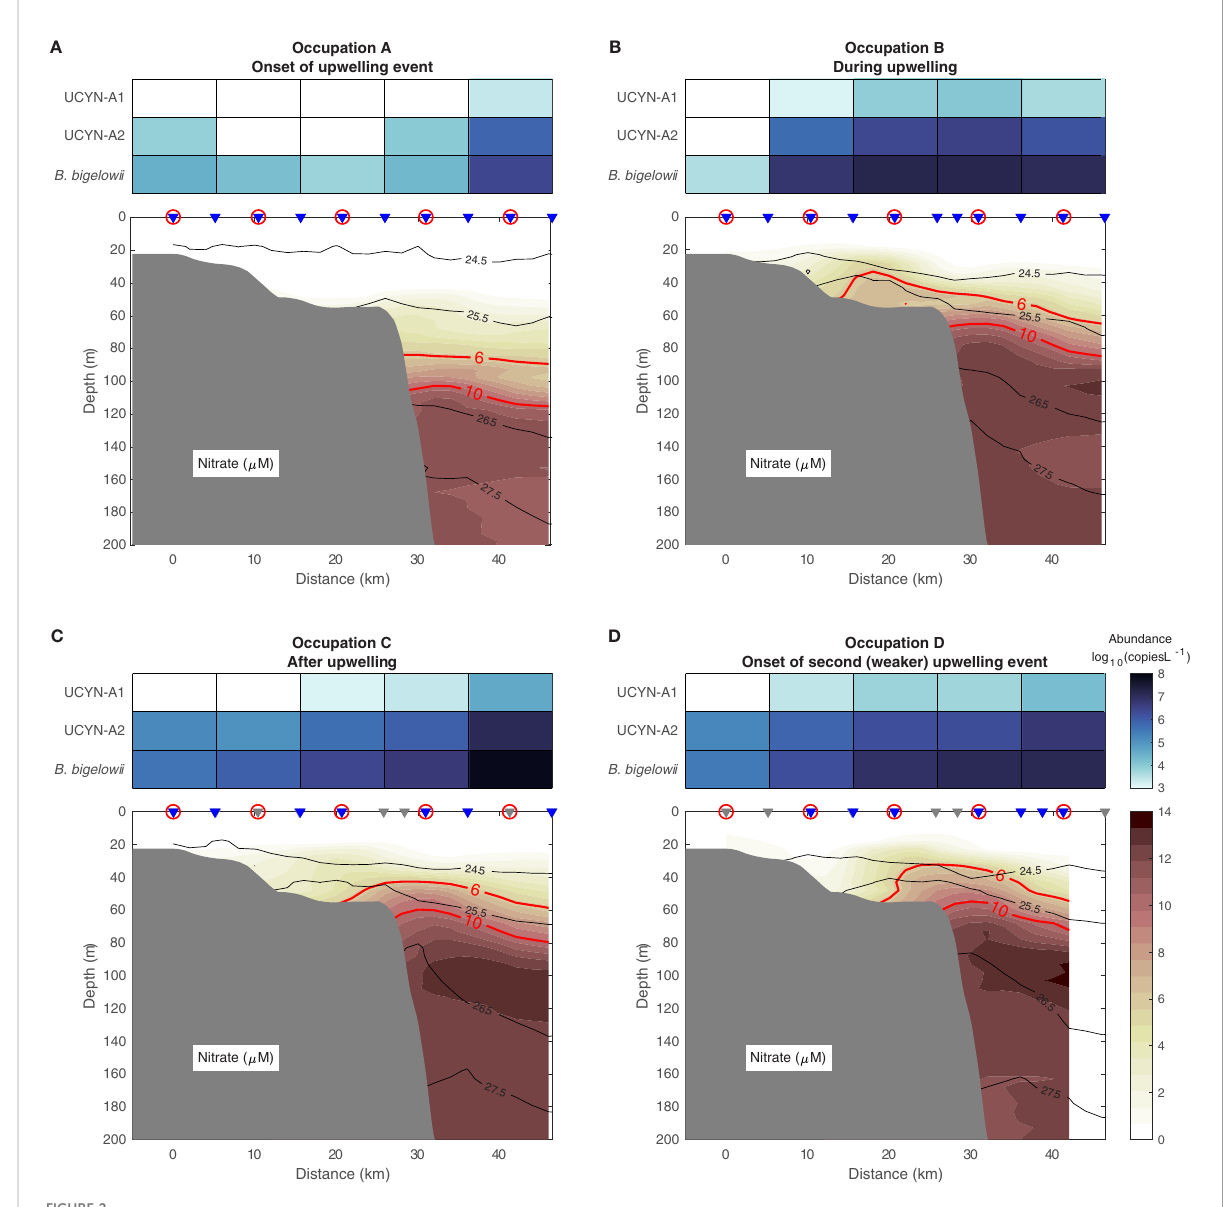
FIGURE 2 Cross-shelf nitrate concentrations, UCYN-A1 and UCYN-A2 nifH gene abundance, and B. bigelowii 18S rRNA abundance (log 10 (gene copies L -1 )) at the onset of the upwelling event [August 30-31, (A) ], during the event [September 1-2, (B) ], after the event [September 3-4, (C) ], and at the onset of a second, weaker upwelling event [September 5, (D) ]. The isopycnals are contoured in black (kg m -3 ). The contours of 6 and 10 m M nitrate are highlighted in red. The grey triangles are CTD-only stations, the blue triangles are the stations where both CTD and nitrate data were measured, and the stations with gene and rRNA abundance measurements are circled. The bathymetry is from the International Bathymetric Chart of the Arctic Ocean version 3.0 (Jakobsson et al.,